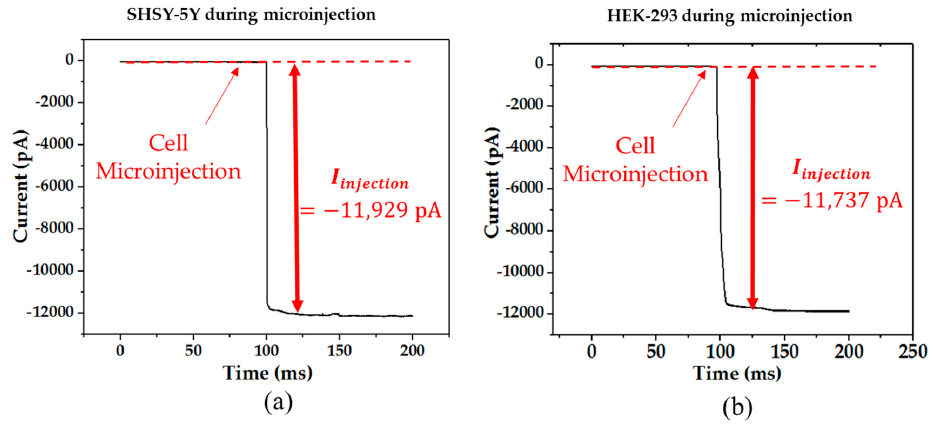
Figure 6. The current response during the cell cytoplasmic microinjection of: ( a ) a SHSY-5Y cell and ( b ) a HEK-293 cell. 4.2. The Current Response for Verifying the Cell Viability after the Cell Cytoplasmic Microinjection